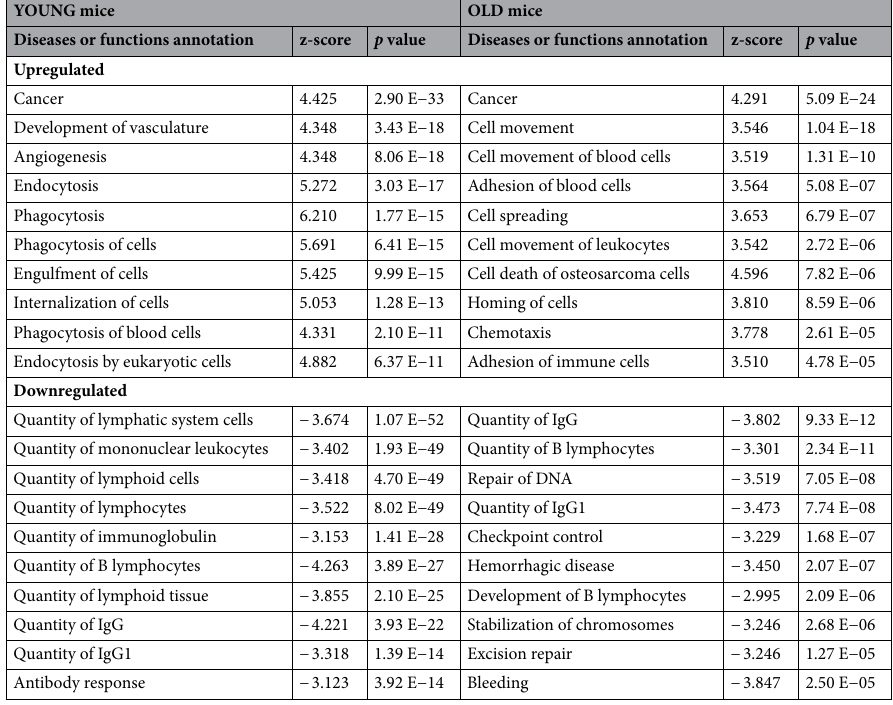
Table 3. Ten most significant (ordered by p value) diseases and functions enriched among upregulated or downregulated genes in irradiated old and young male mice as identified by Ingenuity Pathway Analysis. Benjamini-corrected p value < 0.05 and |z|≥ 2 was considered